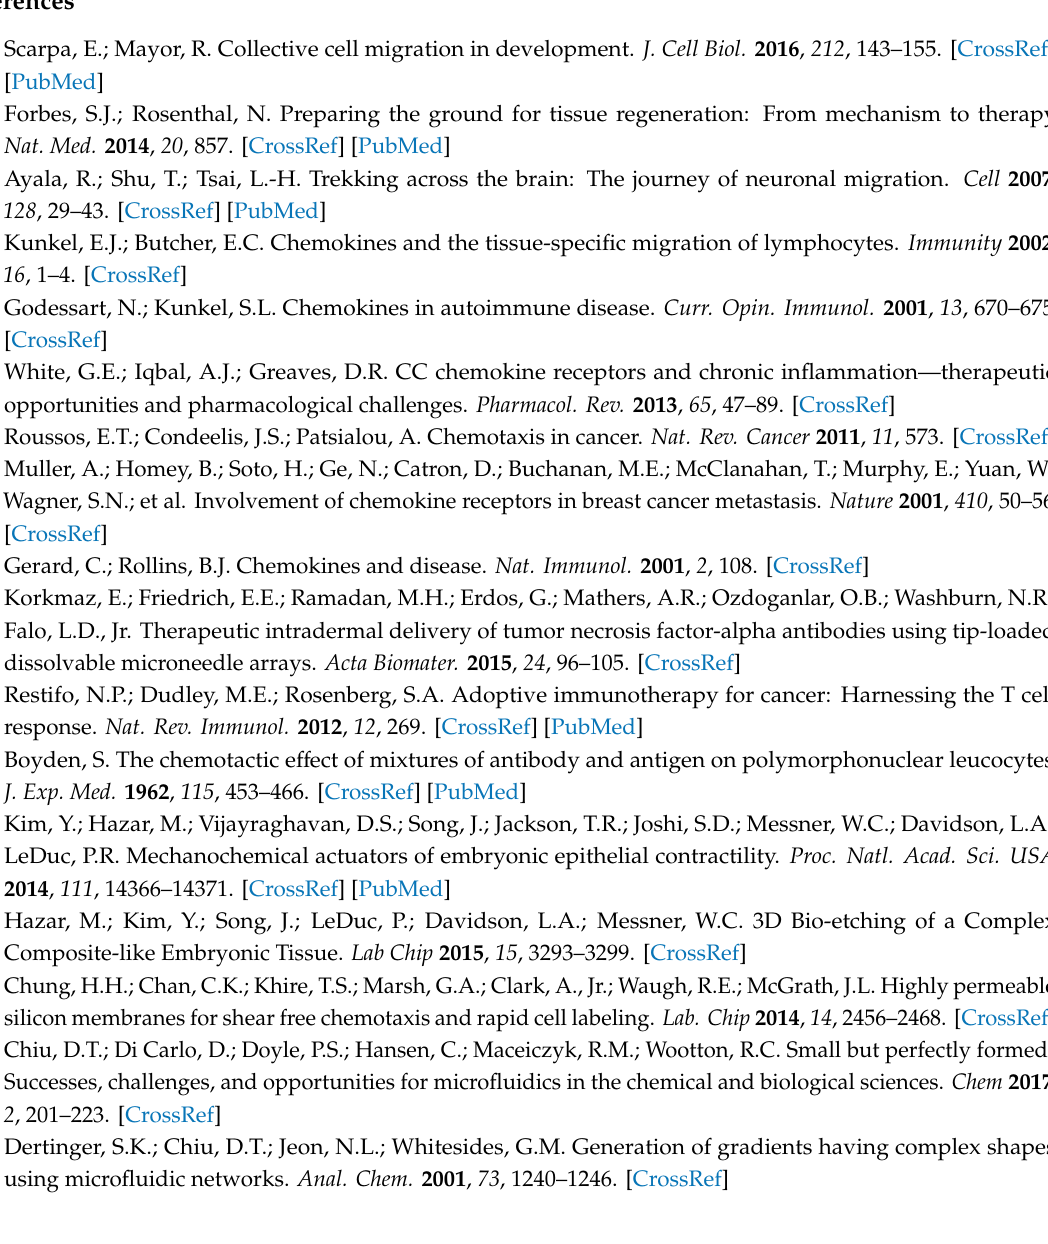
for Jurkat cells. Figure S3: Fluorescent images of Jurkat cells stained with di ff erent concentration of CellTracker Green BOPIDY. Figure S4: Comparison of two di ff erent membrane integration techniques. Figure S5: High resolution images of Jurkat cells stained with CellTracker Green BOPIDY in flow-free microfluidic gradient